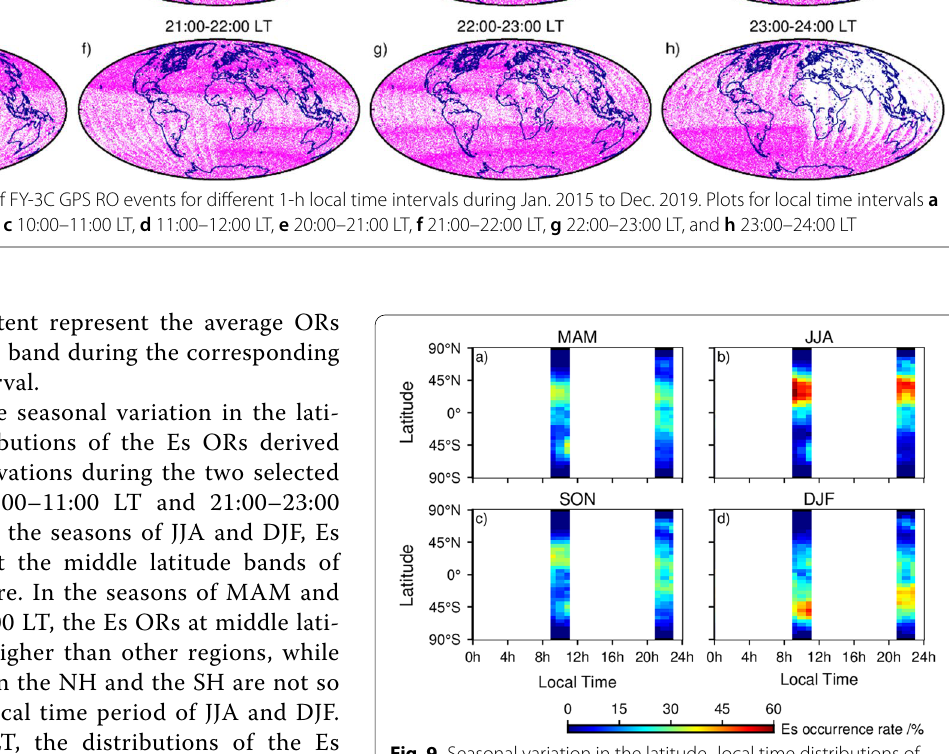
Fig. 9 Seasonal variation in the latitude–local time distributions of FY-3C RO-derived Es occurrence rates for the two local time periods, 9:00–11:00 LT and 21:00–23:00 LT, during Jan. 2015 to Dec. 2019, with a resolution of 5° latitude 1 h. Plots for four different seasons a × MAM, b JJA, c SON, and d